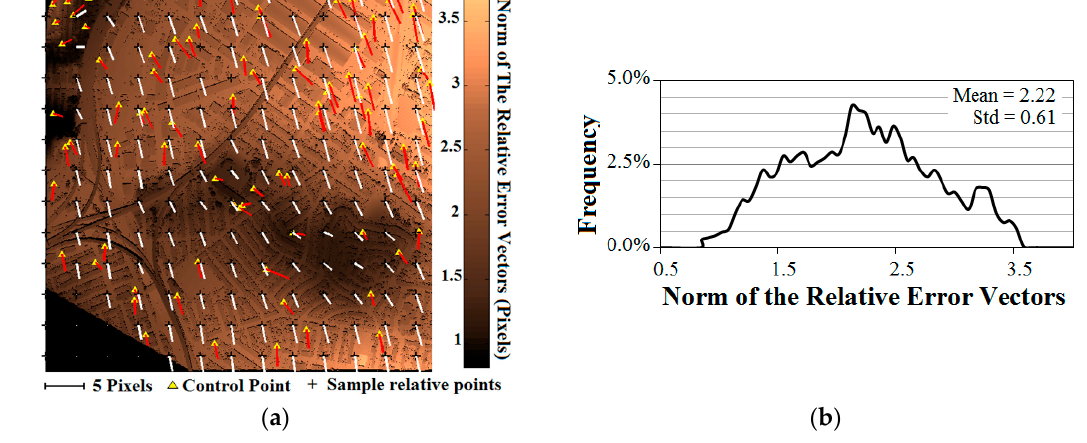
Figure 19. Absolute and relative error vectors with a histogram of the relative errors for the sample dataset: ( a ) Sizes and orientations of the error vectors; ( b ) Length histogram of the relative error vectors. Table 2. RMSE of the sample dataset’s control points estimated by the Coarse 3D-Model. RMSE in